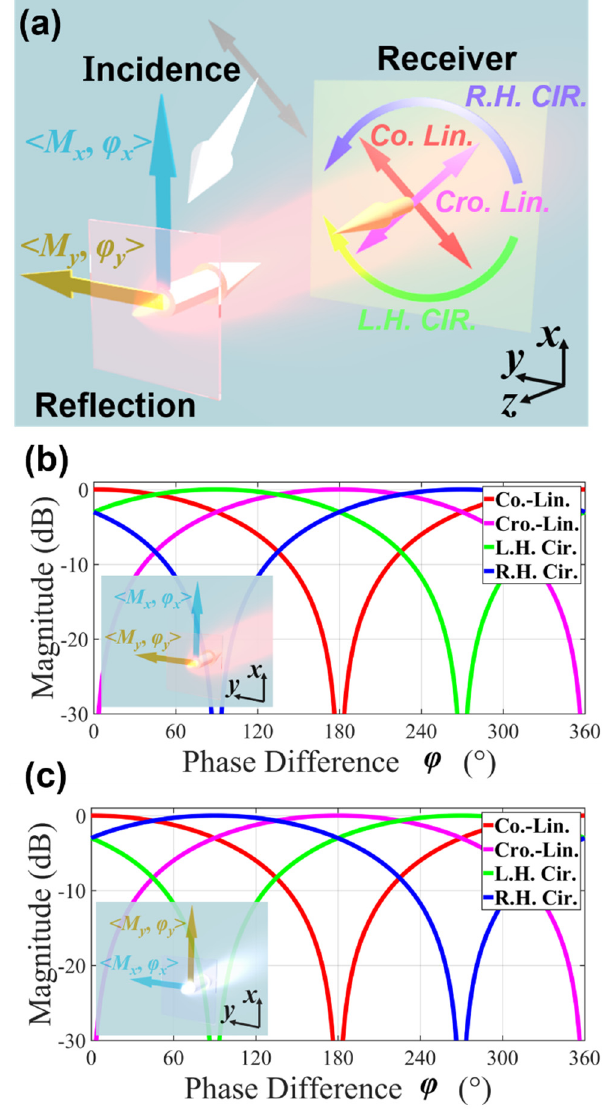
Figure 1. Relationship between the multi-polarized reception of the reflection with an anisotropic magnitude and phase. ( a ) Schematic of the reflection and receiver in the co-, cross linear-polarization and, left-hand, right-hand circular polarization. ( b ) depicts the multi-polarized reception magnitude for the reflective phase states shown in ( a ), while ( c ) shows the multi-polarized reception magnitude in the case of the rotation of the MS by 90°.